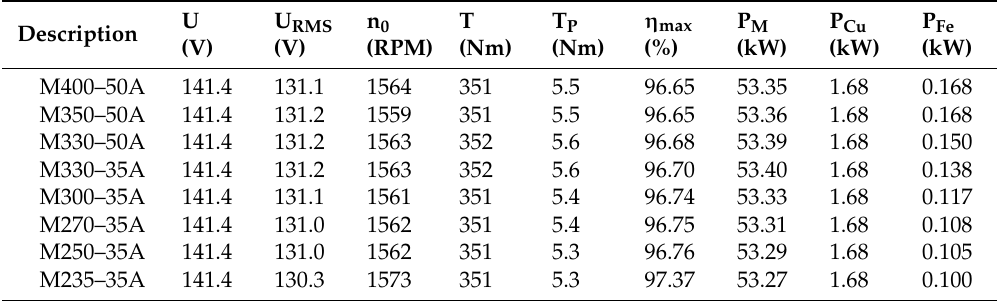
Table 8. Impact of applying various ferromagnetic materials for stator construction on the obtained ERPMSM parameters.